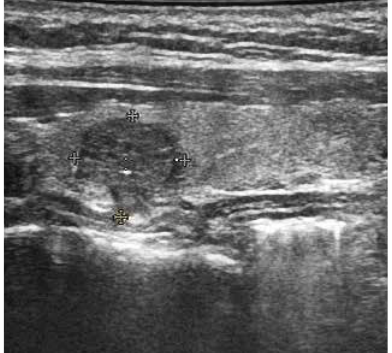
Figure 1 Ultrasonographic appearance of PTMC showing unclear border, microcalcification and anteroposterior diameter greater than 0.7 cm.